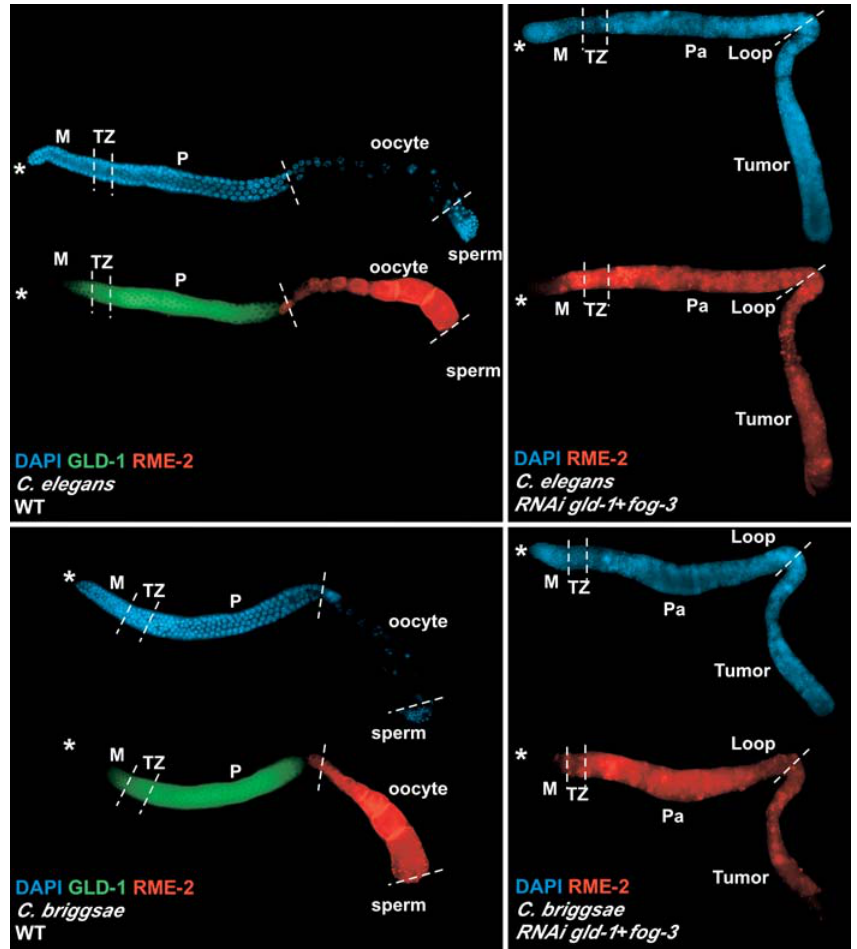
Figure 6. GLD-1-Mediated Translational Repression of rme-2 mRNA in C. elegans and C.